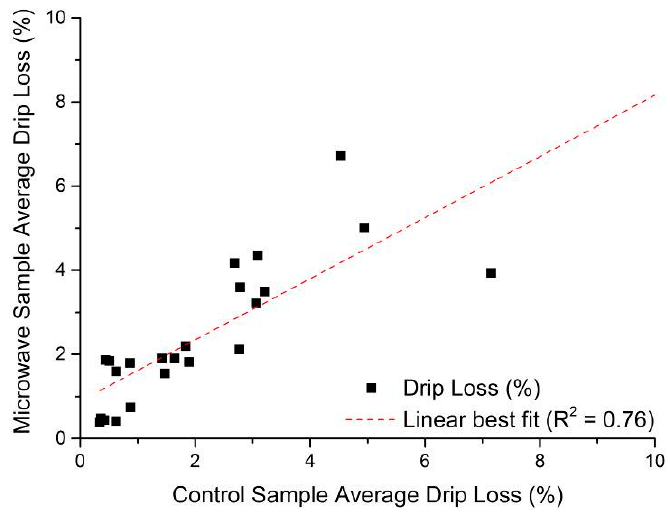
Figure 6. Correlation of drip loss in control sample and the portion of pork loin used for microwave measurement in this work, where R 2 = 0.76.